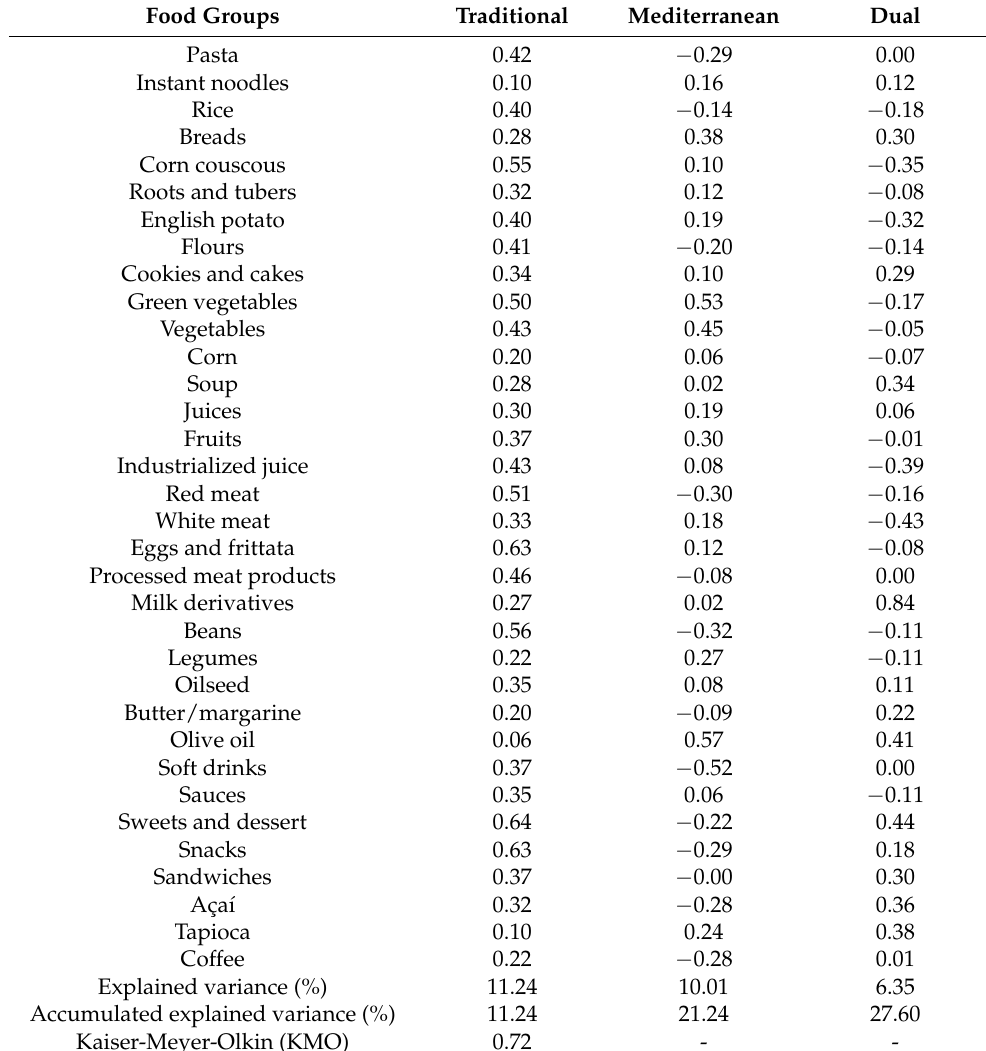
Table 3. Factor load of dietary patterns of patients hospitalized for HF decompensation in Sergipe ( n = 240),